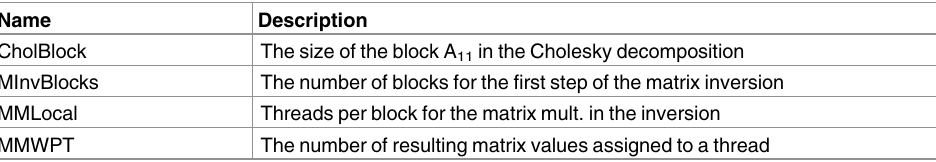
Table 2. Implementation parametersfor the